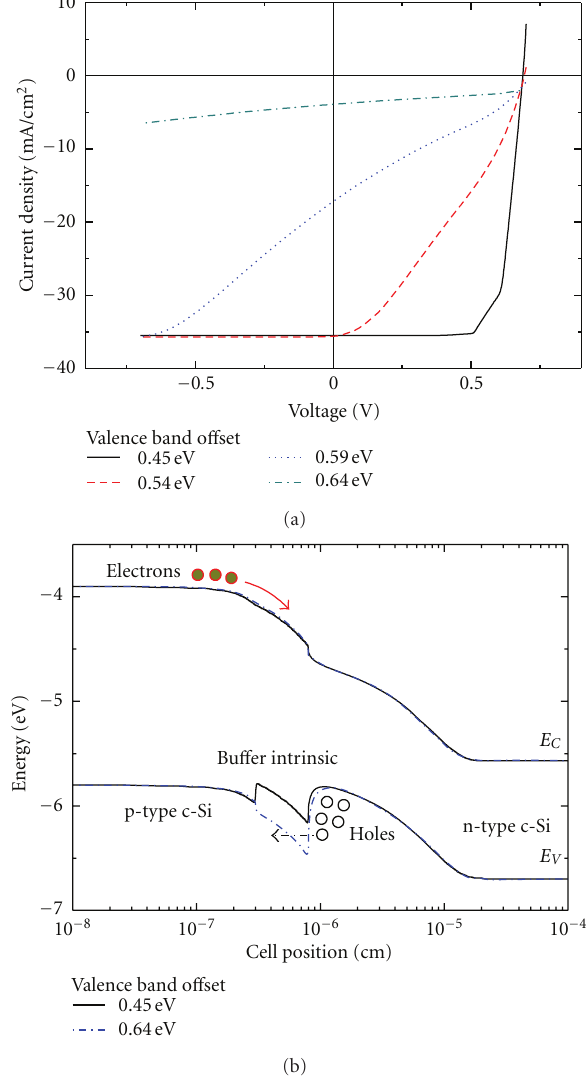
Figure 5: (a) Simulated I-V curve with di ff erent energy band gap of passivation layer, (b) schematic of the band diagram depend on energy band gap of passivation